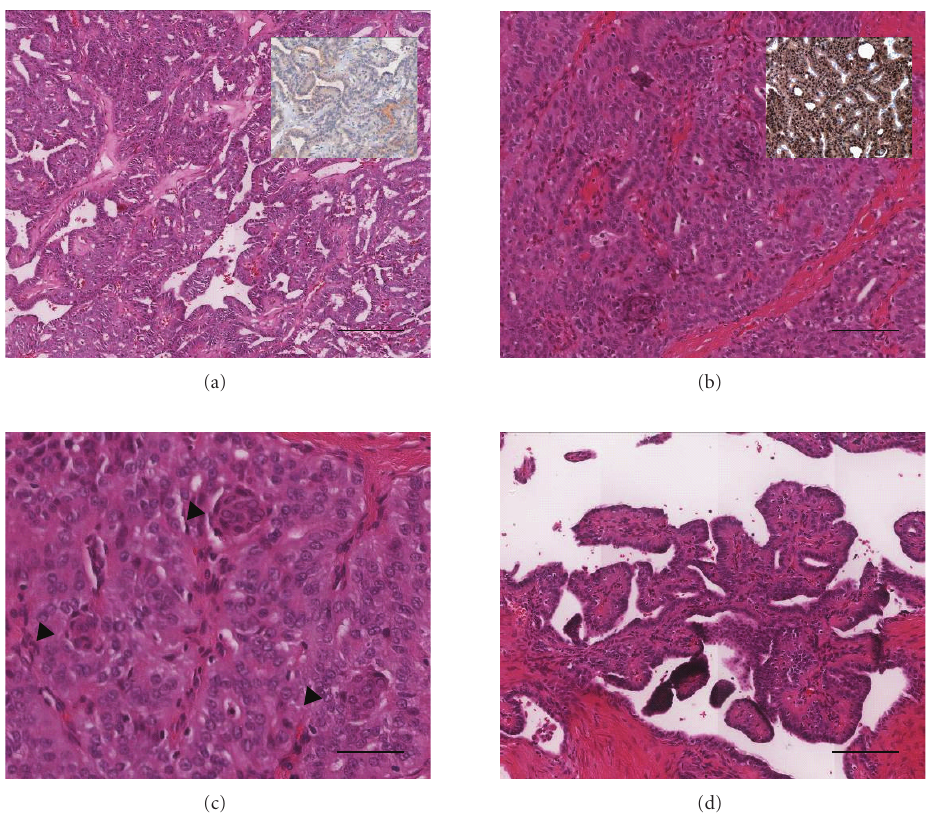
Figure 1: Histological features of CMV variant of PTC. Representative pictures of the tumour show the cribriform structures composed of follicles deficient in colloid and lined by flattened to low cuboidal epithelial cells with scant intervening fibrous tissue (a). The tumor cells were weakly positive by immunohistochemistry for thyroglobulin ((a)-inset), but showed nuclear localization with immunostaining for beta-catenin ((b)-inset). Other portions of the tumor nodules had a trabecular arrangement (b, c) of tall columnar cells with small whorls of cells (arrowheads). The cells within the whorls had nuclei with a pale eosinophilic to clear appearance (c). A minor papillary component was present within the periphery of the tumor nodule (d). The tumor cell nuclei were oval and overlapping with irregular outlines. Nuclear grooves were readily identified and occasional typical intranuclear cytoplasmic pseudoinclusions were present. Magnification bar: (a) × 40, (b & d) × 100, and (c) ×